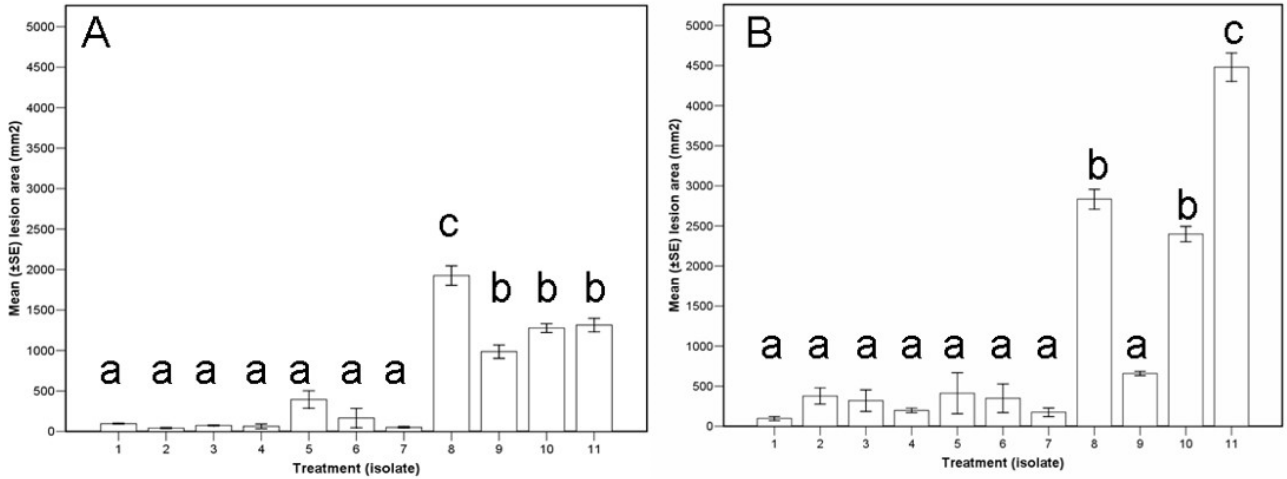
Figure 3. Lesion area 53 days after individual inoculation (assay I) with ten isolates of Cryphonectria parasitica (1–3 infected with the hypovirus CHV1 ‐ M2273, 4–6 infected with CHV1 ‐ M2357, and 8–11 virus ‐ free isolates) and a PDA control (number 7). (Eleven treatments). Bars with the same letter are not significantly different based on Tukey´s test. ( A ) Seedlings ( n = 44). ( B ) Branch segments ( n = 33). See Material and Methods third paragraph for experimental details.3.4. Assay II, biocontrol potential.